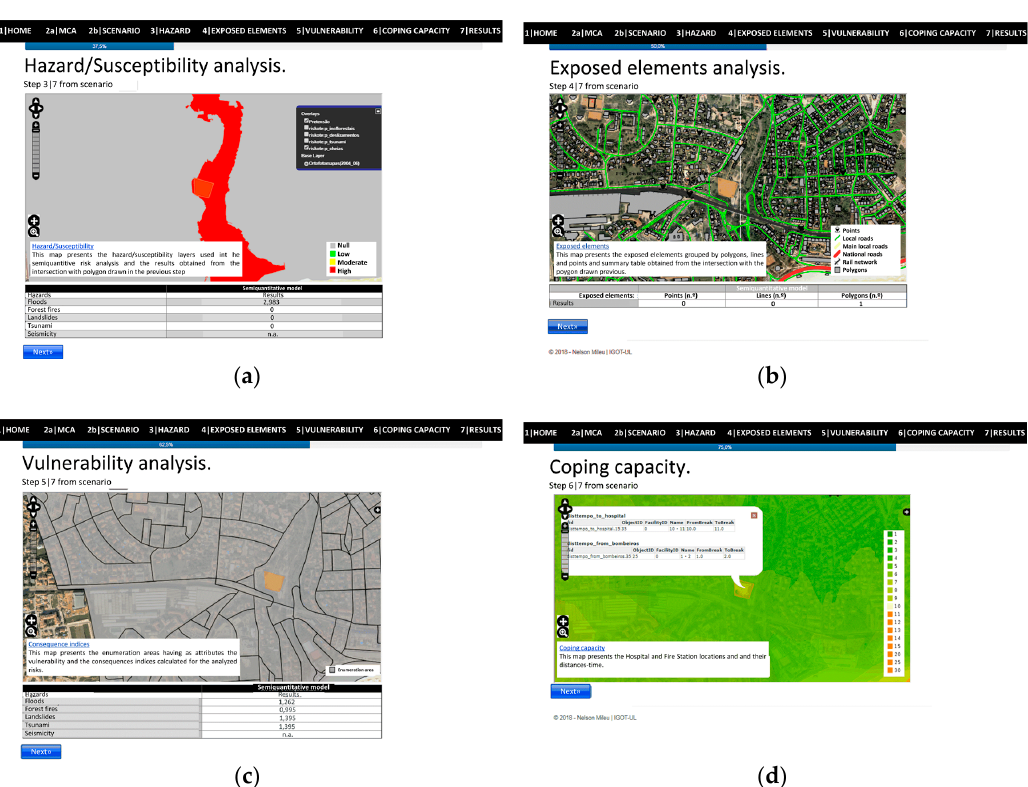
Figure 12. RiskOTe SDSS analysis steps: ( a ) Hazard; ( b ) Exposed elements; ( c ) Vulnerability/consequence indexes; ( d ) Coping capacity.